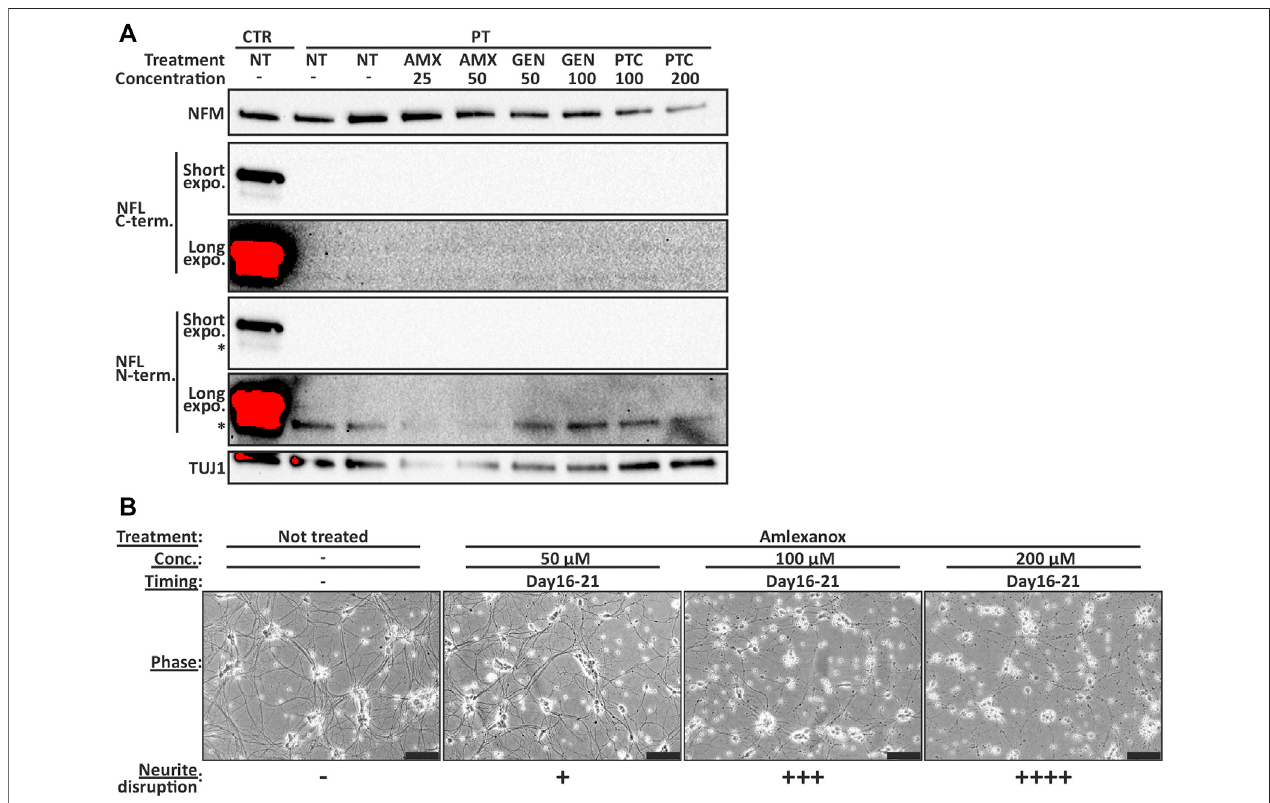
FIGURE6 | NFL protein is notinducedto detectable levels by TRID orNMDi treatmentin PTiPSC-MN. (A) Immunoblottingseries (same blotsequentially analyzed withdifferentantibodies)showsnodetectablefull-lengthNFLintreatedpatient motorneurons.ShortandlongexposuretimesshownwithtwoseparateNFLantibodies. Treatment between days 16 – 25 with 25 and 50 µM of amlexanox (AMX), 50 and 100 μ g/ml of gentamicin (GEN) and 100 and 200 µM of PTC-124 (PTC). Asterisk indicatesanunspeci fi cbanddetectedbytheNFL antibody. Concentration asµM forAMXand PTC,and µg/mlforGEN. (B) Representativeimages ofAMX toxicity in day 21 motor neurons (treated for 5 days). Motor neuron health is categorized to — no effect, + some neurite swellings, ++ swellings in most neurites, +++ neurite disruption and ++++ severe neurite disruption and cell death. Higher concentration causes more severe disruption. Scale bar 100 µm.